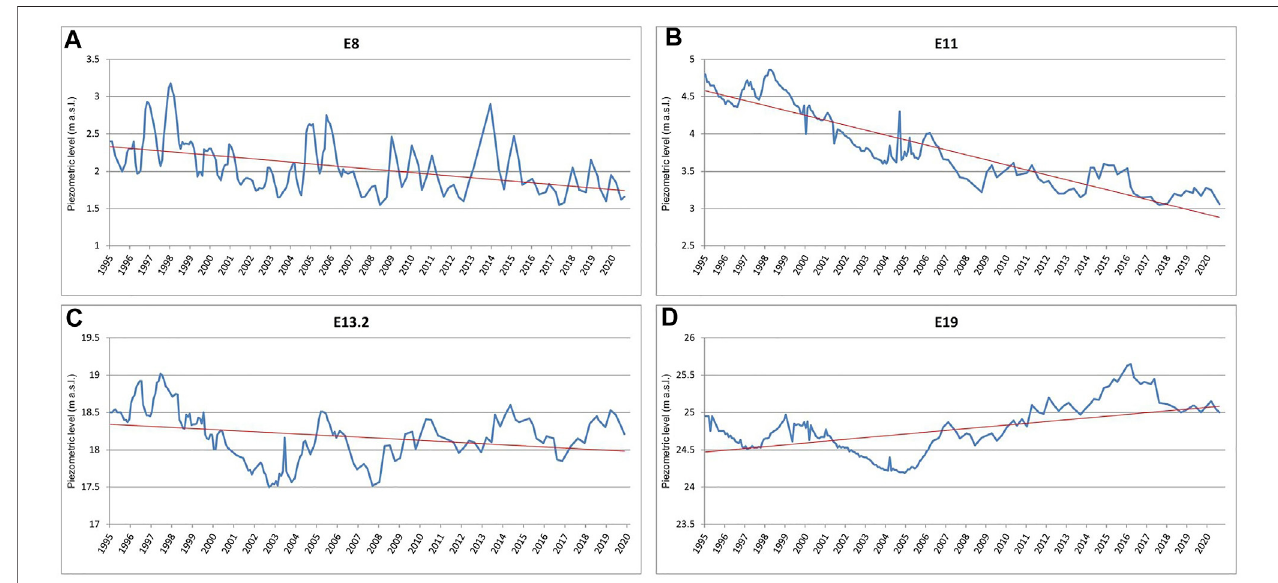
FIGURE 5 | Piezometric trend over time of four representative monitoring wells: E8 [coastal area, (A) ], E11 [central area, (B) ], E13.2 [northern area, (C) ], and E19 [eastern area, (D) ].